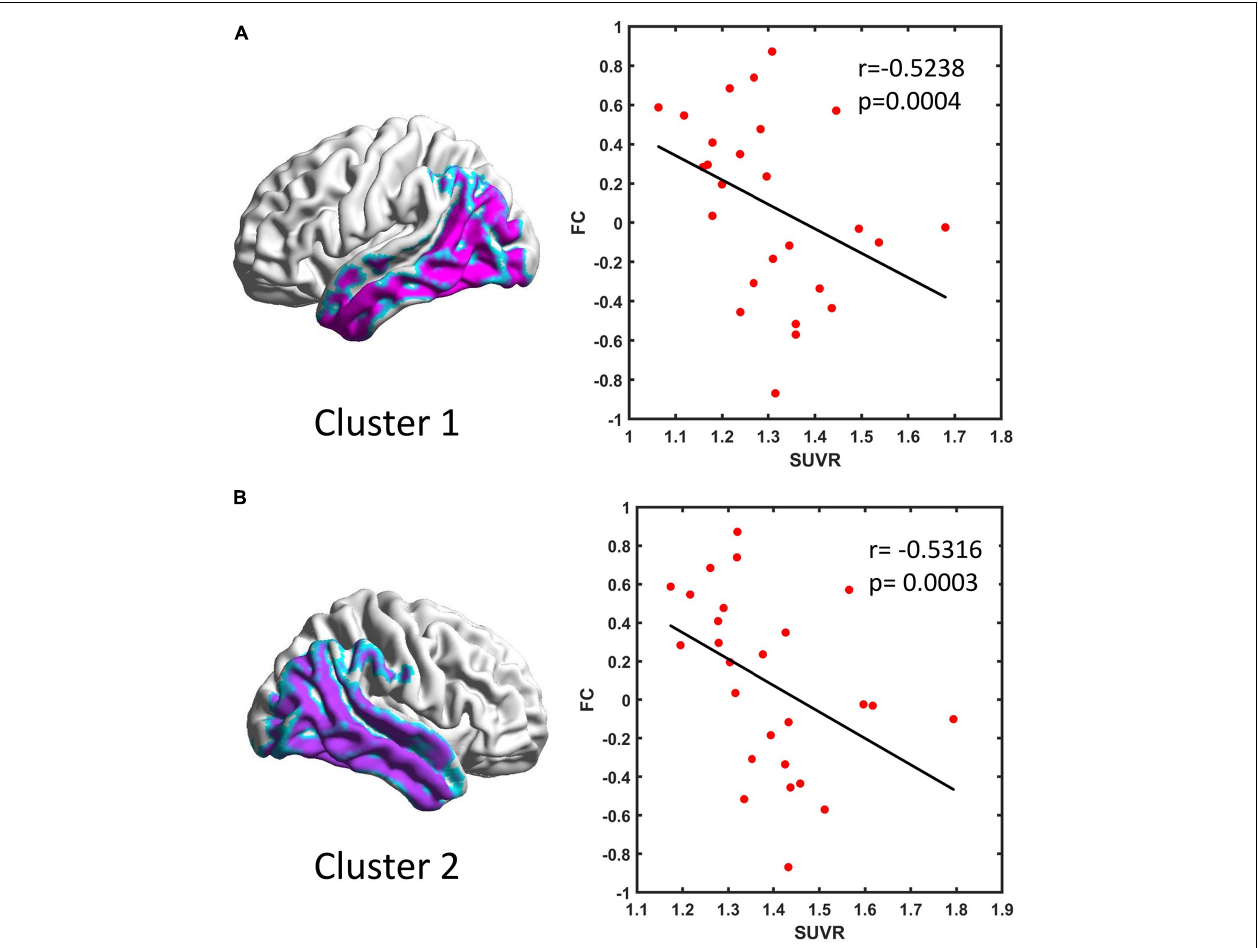
FIGURE 2 | Scatter plot of the functional connectivity and standardized uptake value ratio (SUVR) in Cluster 1 (A) and Cluster 2 (B) in Alzheimer’s disease patients.